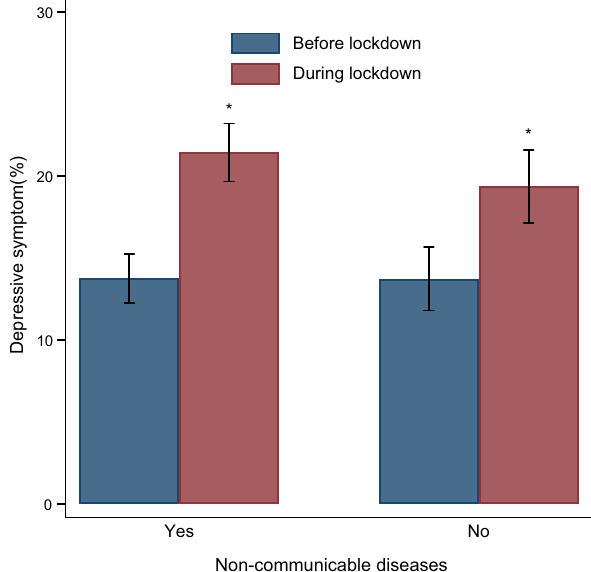
Figure 2. Depressive symptom before and during the nationwide COVID-19 lockdown in Hangzhou, China. *p < 0.05, for the difference before and during lockdown using McNemar’s